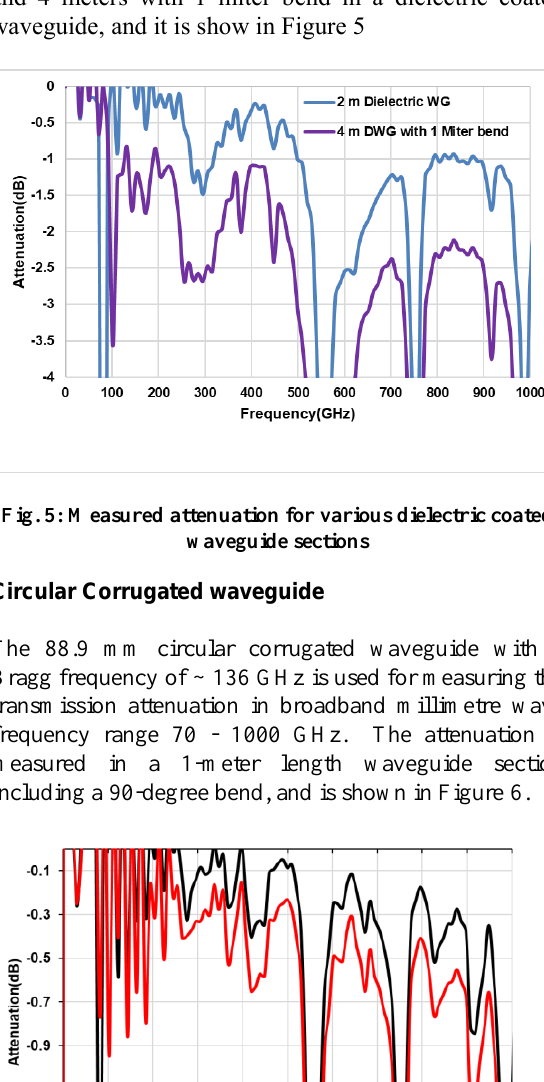
Fig. 8: Spectra of 10 m smooth TL in air and vacuum medium The transmission attenuation is compared for the two cases and the preliminary result show that the attenuation is reduced in the case of evacuated TL and overall transmission is also